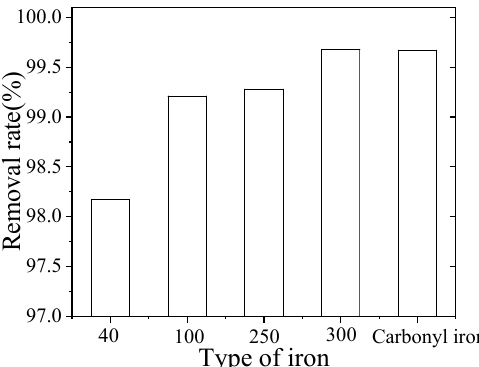
Figure 1. Effect of particle size of the industrial iron powder on As(V) removal.